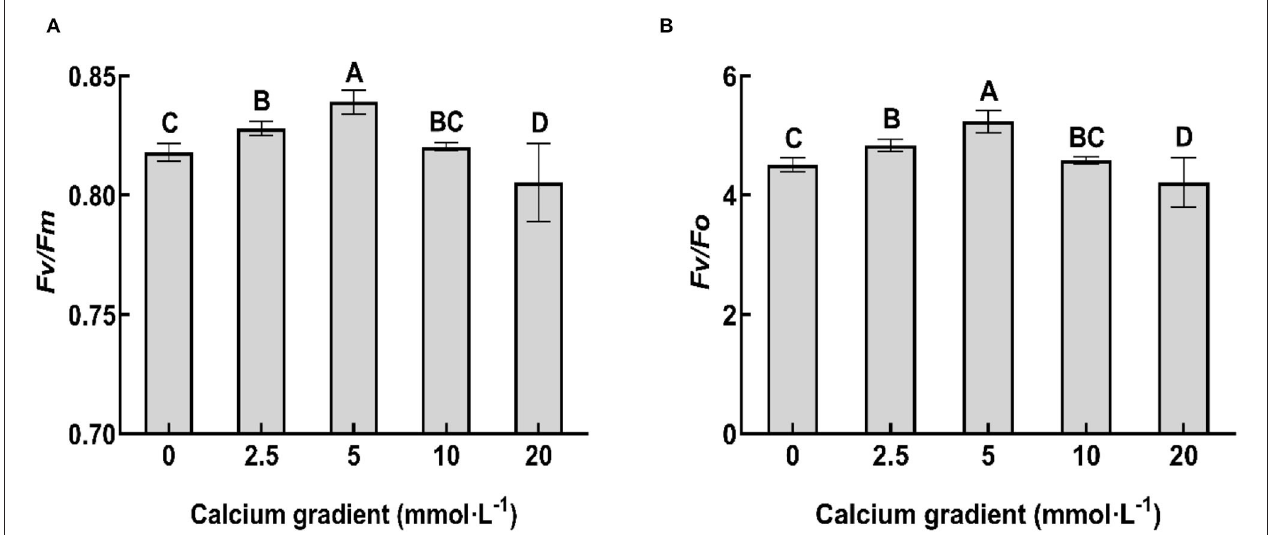
FIGURE 4 | Chlorophyll fluorescence parameters of poplar seedlings in different treatments. Fv/Fm ratio indicates the maximum photochemical efficiency, and Fv/F0 ratio indicates the potential photochemical efficiency. Each column represents the mean ± SE value, n = 3; different capital letters indicate significant differences between treatments with different concentrations of calcium ( P <